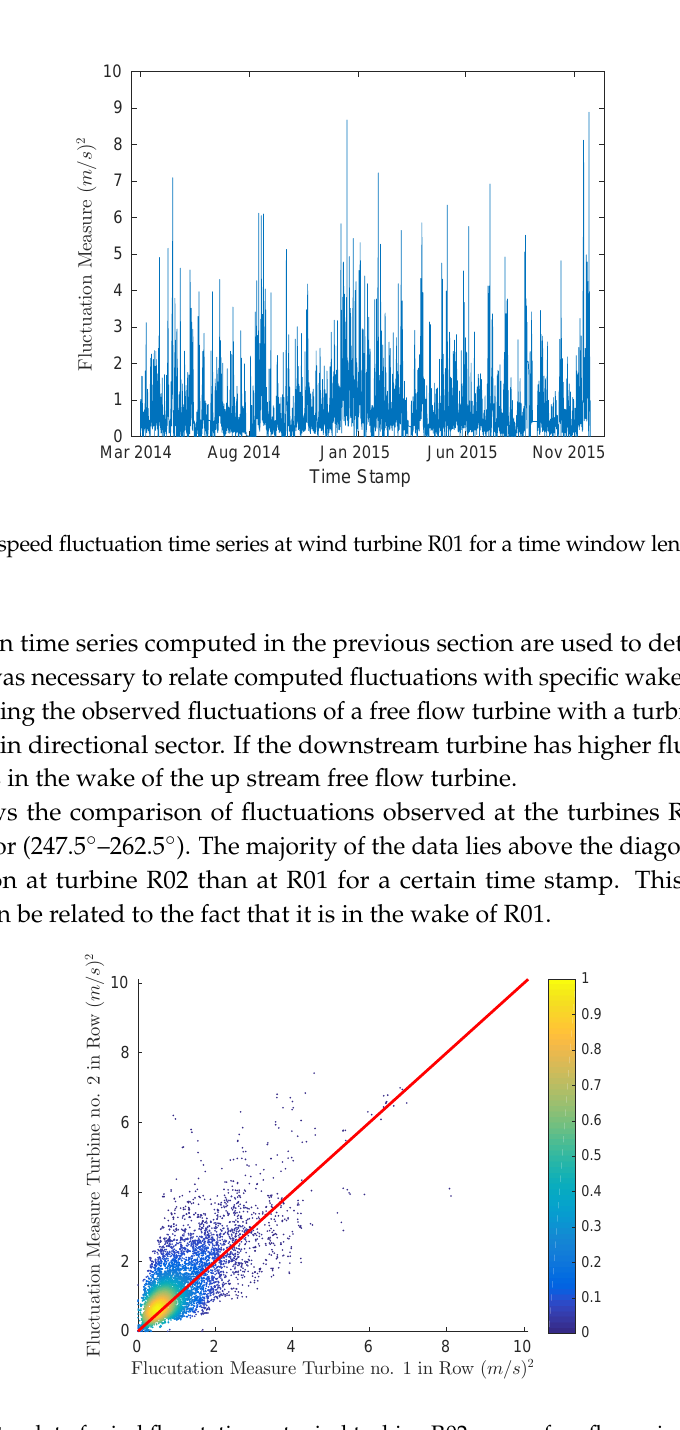
Figure 3. Density plot of wind flucutations at wind turbine R02 versus free-flow wind turbine R01 for the westerly wind